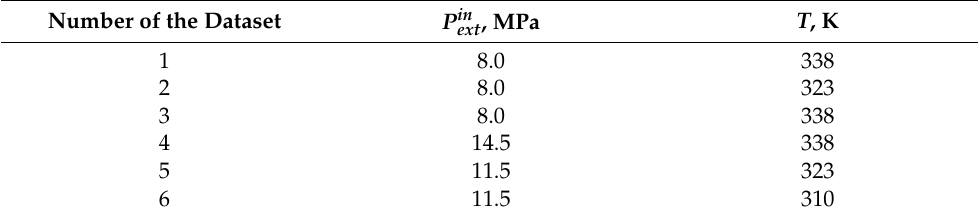
Figure 4. Depressurization-driven expansion of bubble embryos depending on the temperature and initial pressure. Smoothed current radii of expanding embryos are displayed against the current values of P ext ( a ) and 1 − P ext / P ext ,0 ( b ). Table 1. The experimental conditions for the datasets 1–6 (Figure 4, Figure 5a).